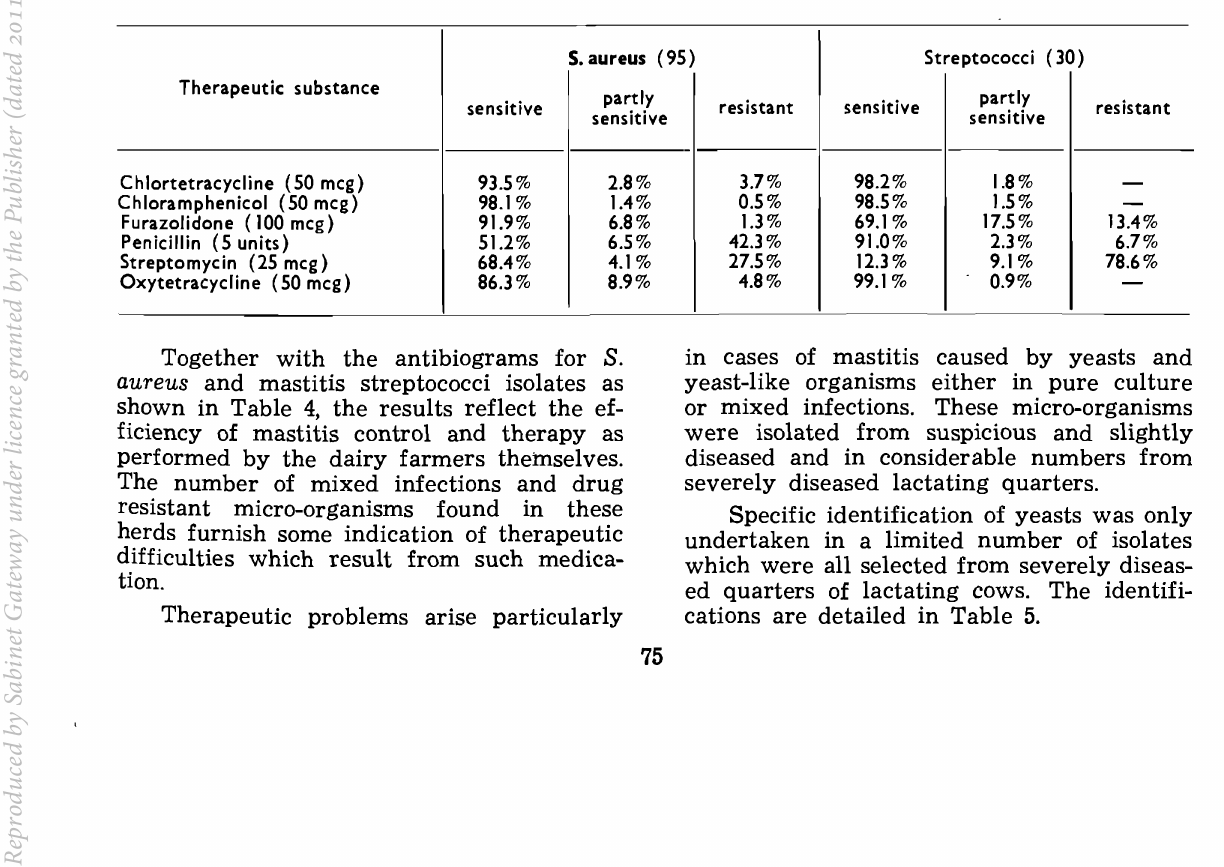
Table 4: DRUG SENSITIVITY OF STAPHVLOCUCCUS AUREUS AND STREPTOCOCCUS ISOLATES